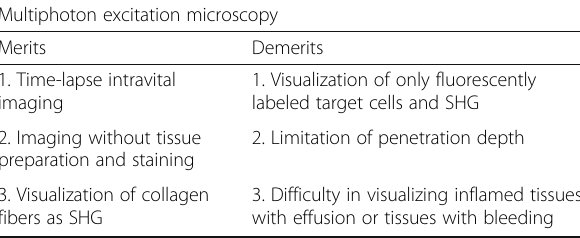
Table 4 Merits and demerits of multiphoton excitation